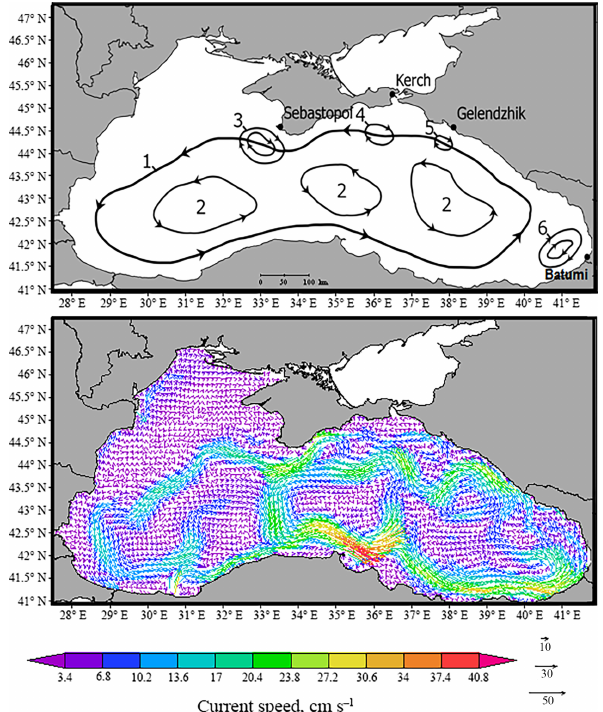
Figure 7. General surface circulation scheme of the Black Sea (top panel; 1 – mean position of the cyclonic Rim Current; 2 – quasi-stationary cyclonic gyres; 3 – Sebastopol; 4 – Kerch; 5 – Ge- lendzhik; 6 – Batumi quasi-stationary anticyclonic gyres) and the INMOM modeled Black Sea circulation at a depth of 10m, aver- aged for June 2011 (bottom